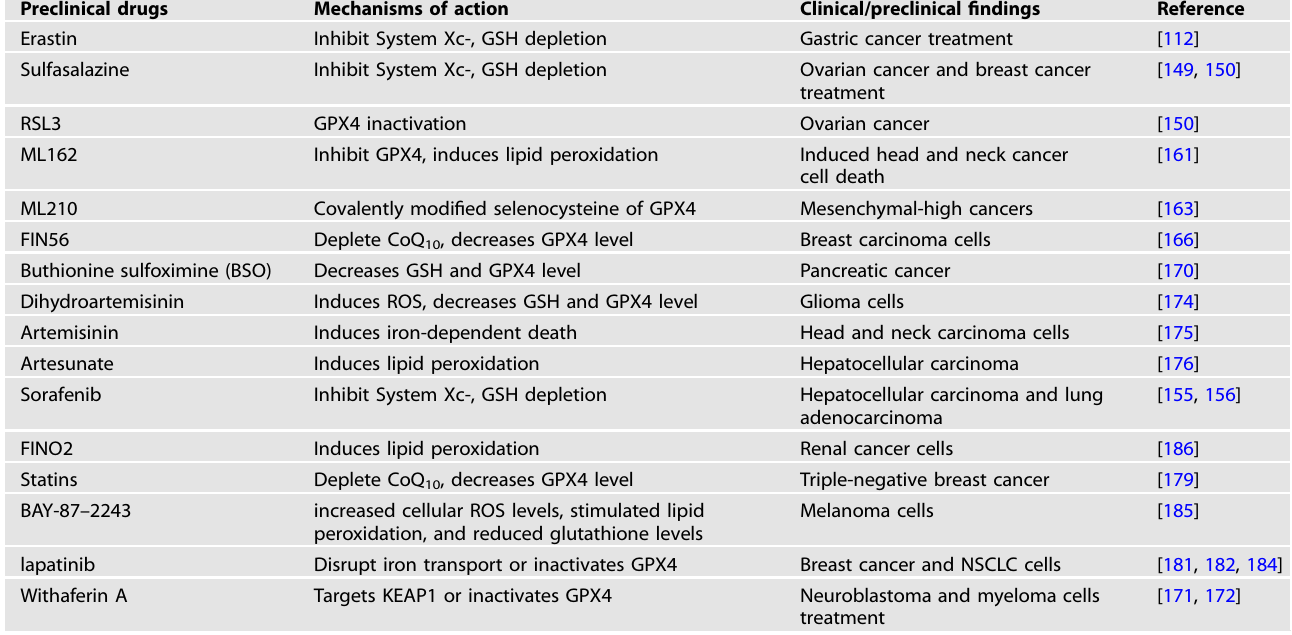
Table 4. Preclinical drugs associated with